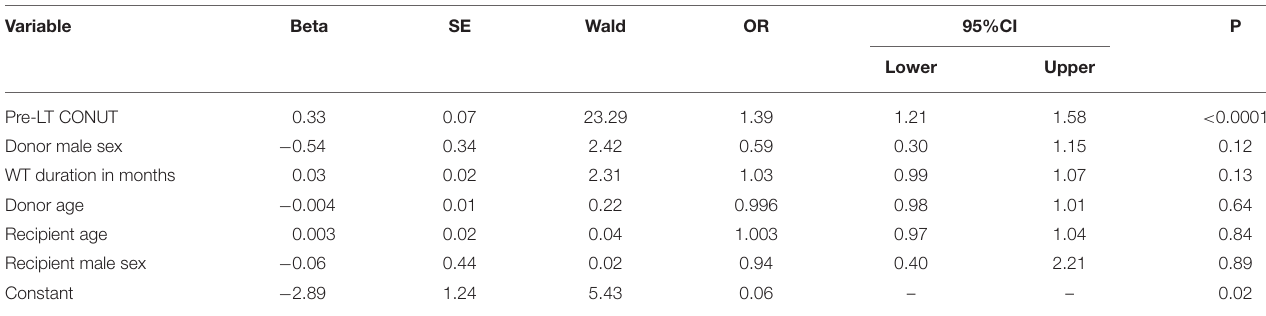
TABLE 4 | Multivariable logistic regression model for the risk of CCI